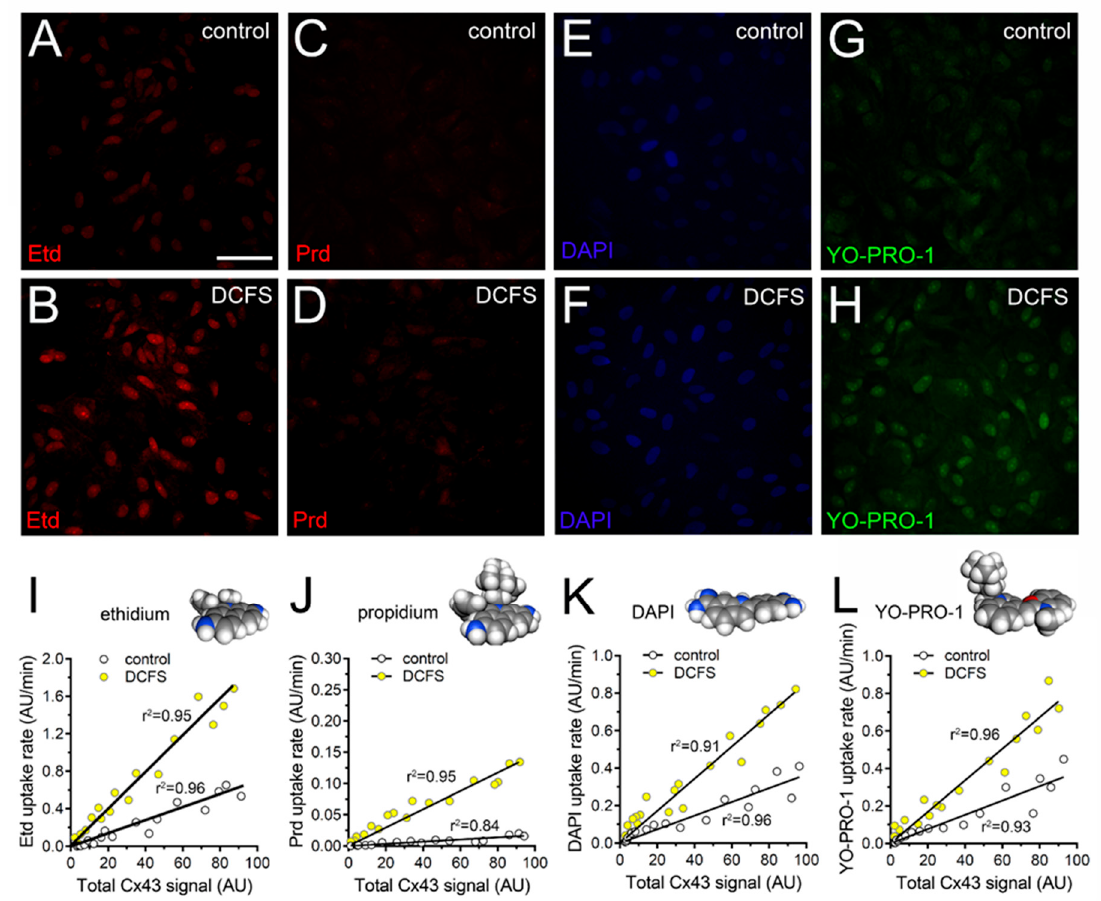
Figure 1. Uptake of nucleic acid dyes is directly proportional to total amount of Cx43 in cultured astrocytes. ( A – H ) Representative fluorescence images depicting Etd ( A , B ), Prd ( C , D ), DAPI ( E , F ), and YO-PRO-1 ( G , H ) staining from dye uptake measurements (10 min exposure to each dye) in astrocytes bathed in control saline or a divalent cation-free solution (DCFS). ( I – L ) Representative plots of linear regression analysis showing the close relationship between uptake rate of Etd ( I ), Prd ( J ), DAPI ( K ) or YO-PRO-1 ( L ) and total immunostaining signal for Cx43 in astrocytes bathed in control saline (white circles) or DCFS (yellow circles). The values for Pearson ′ s r were statistically significant ( p < 0.0001) for all dyes studied: Etd (control: 0.96; DCFS: 0.95), Prd (control: 0.84; DCFS: 0.96), DAPI (control: 0.93; DCFS: 0.96) or YO-PRO-1 (control: 0.94; DCFS: 0.96). Space-filling models for the atomic structure of each dye were elaborated with the MolView GPL software (carbon: gray, hydrogen: dark gray, and nitrogen: blue). Calibration bar: 50 µm.